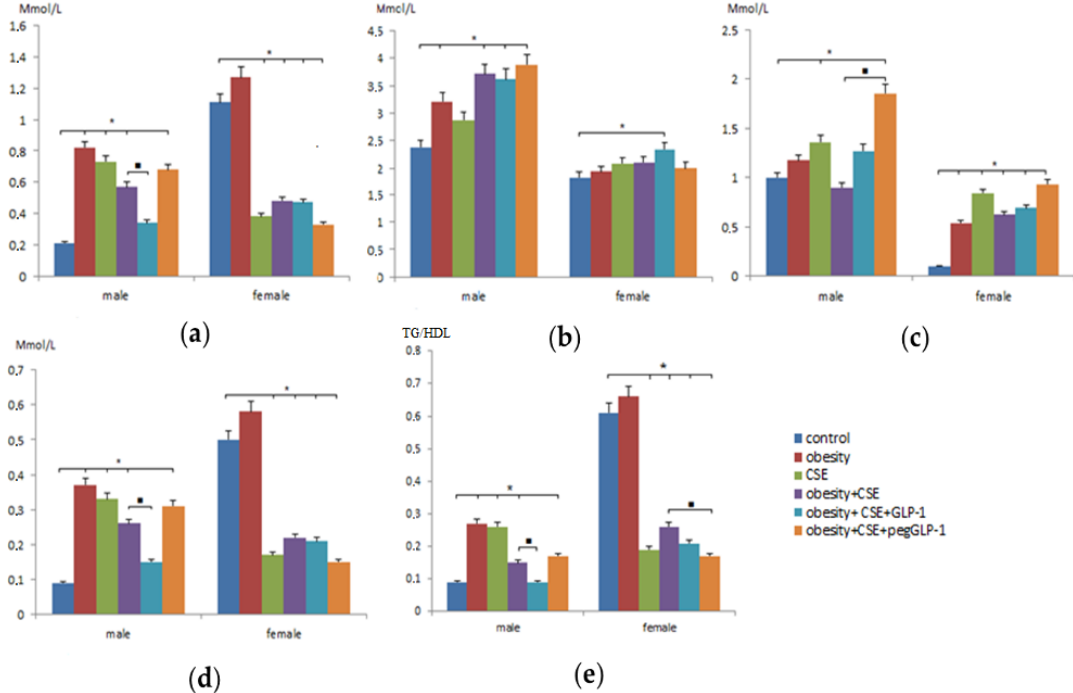
Figure 2. Lipid profile measurements in the blood of female and male C57BL / 6 mice on p189: ( a ) The level of triglycerides in serum (Mmol / l); ( b ) High-density lipoprotein level (Mmol / l); ( c ) Low-density lipoprotein level (Mmol / l); ( d ) Very low-density lipoprotein level (Mmol / l); ( e ) The ratio of triglycerides to high-density lipoproteins (TG / HDL). Groups: control—a control group from intact mice, obesity—mice with metabolic disorders (obesity and hyperglycemia), CSE—mice with lungs emphysema, obesity + CSE—mice with metabolic disorders (obesity and hyperglycemia) and lungs emphysema, obesity + CSE + GLP-1—mice with metabolic disorders (obesity and hyperglycemia) and lungs emphysema treated with GLP-1, obesity + CSE + pegGLP-1—mice with metabolic disorders (obesity and hyperglycemia) and lungs emphysema treated with pegGLP-1. *—significance of di ff erence compared with control ( p < 0.05); (cid:4) —significance of di ff erence compared with the obesity + CSE group ( p <